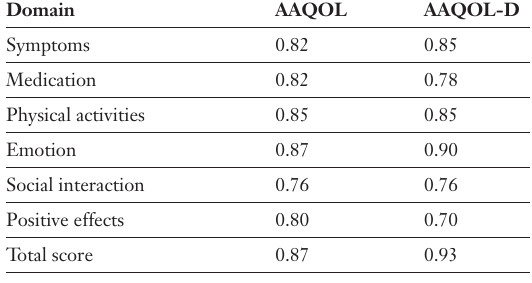
Spearman rank corre- lations between dif- ferent health out- come measures and with asthma severity